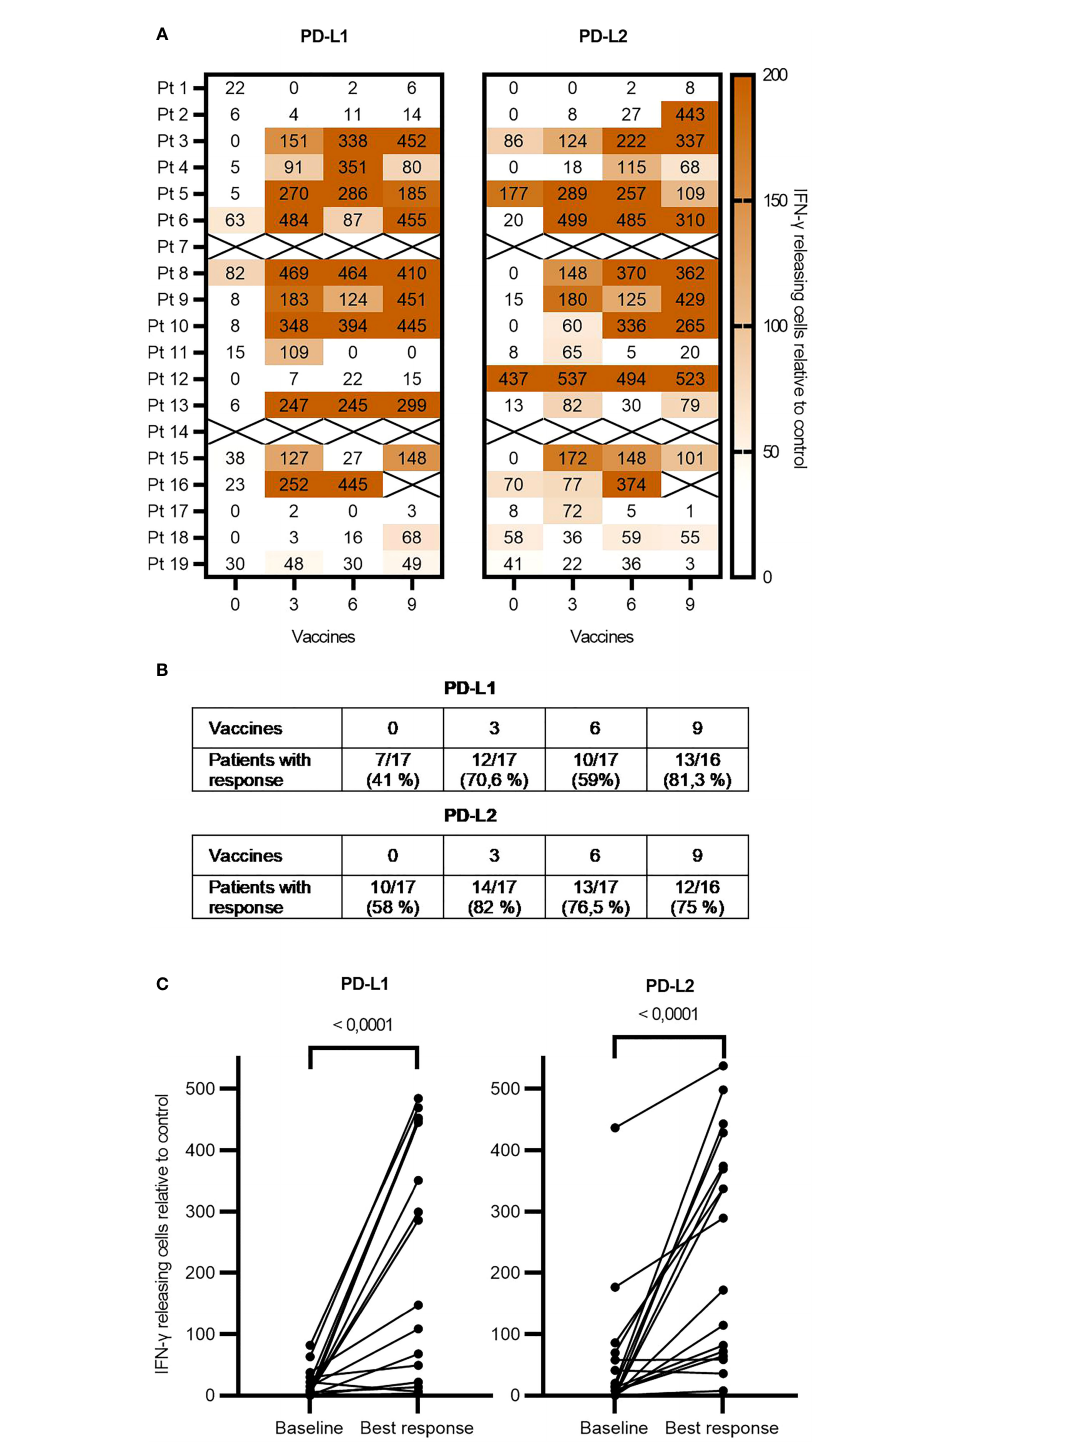
FIGURE 4 ELISPOT responses of individual patients over time. (A) ELISPOT analysis showing the immune responses of each patient at each timepoint during vaccination. The spot count is in relation to the control and based on the mean of triplicates. (B) Table showing the fraction of responses at each timepoint counting statistically signi fi cant responses de fi ned by DFR, DFR (2×), and the empirical response de fi nition. (C) Graph comparing the baseline level of T-cell responses to the best response during vaccination using the Wilcoxon test. ELISPOT, enzyme-linked immunospot; DFR, distribution-free